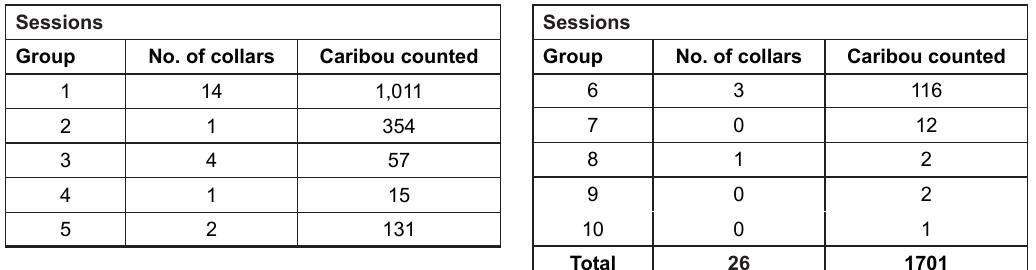
Log-likelihood scores and Rivest estimates were identical for all models which indicates that all the groups were very detectable (sighting probability=1). The Lincoln-Petersen estimate equaled the count of caribou observed given that all the collars were accounted for in observed